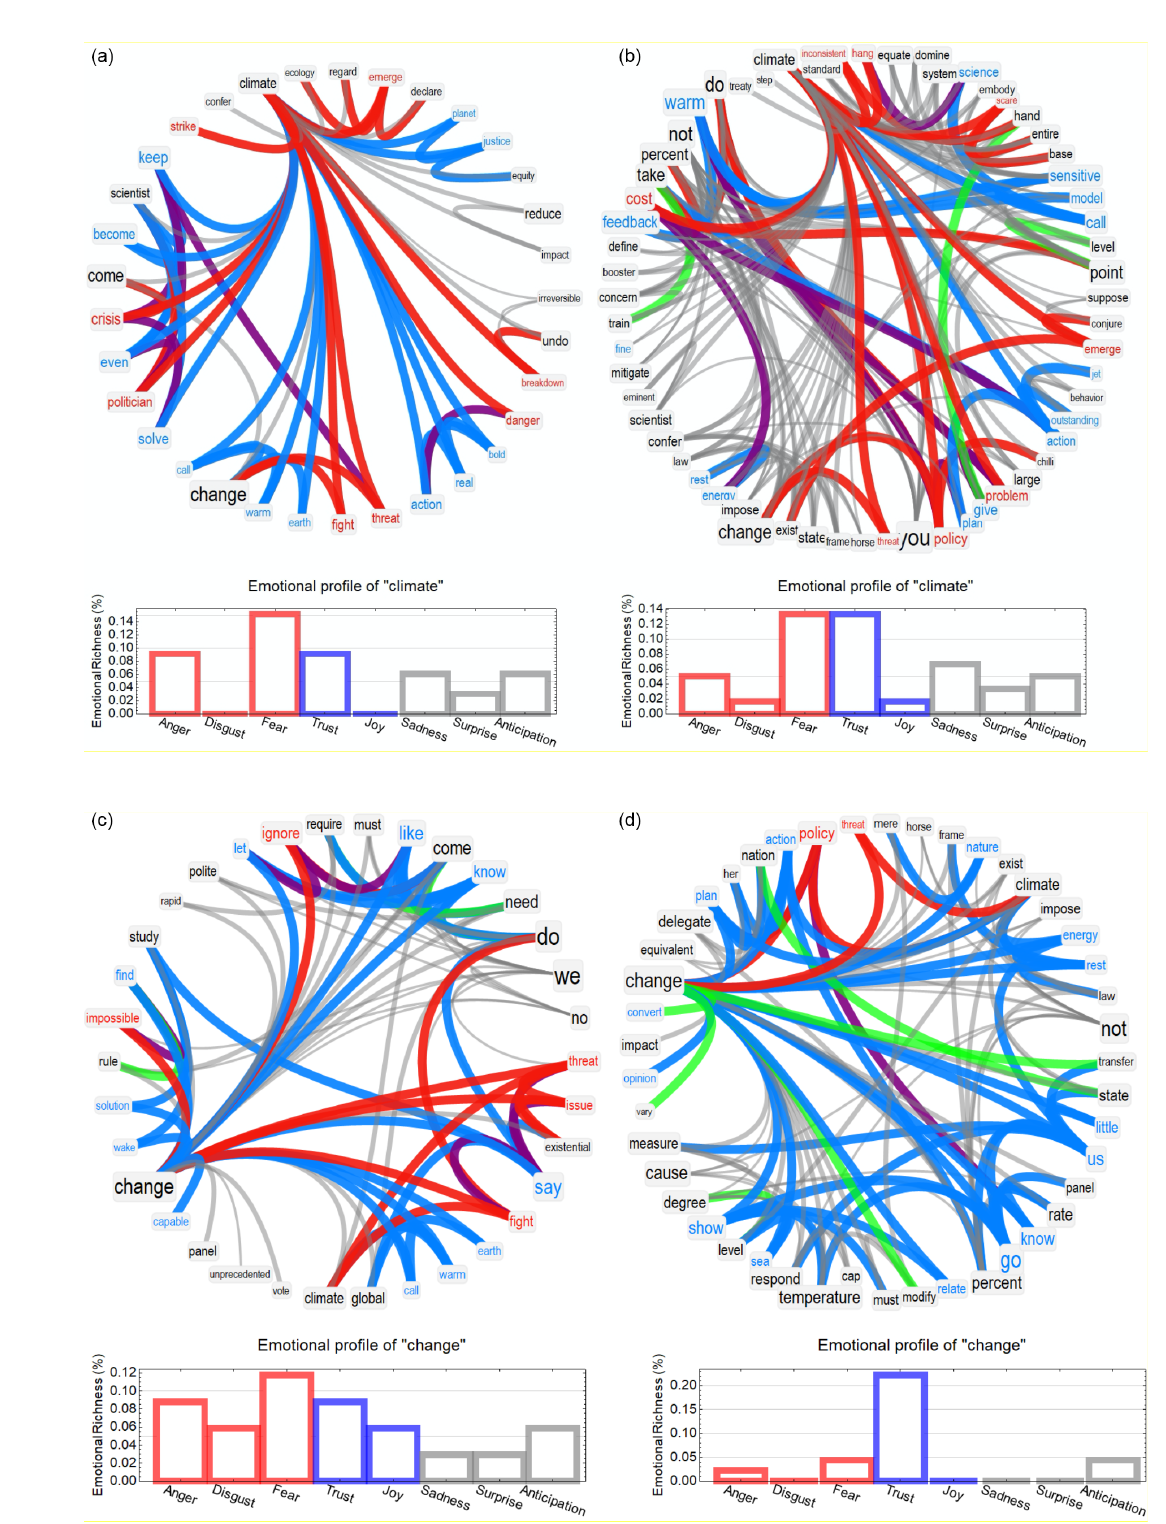
Figure 1. Speakers’ mindset reconstruction around “climate” (a, b) and “change” (c, d) in the speeches of Greta Thunberg (a, c) and Christopher Monckton (b, d) . Links indicate syntactic and semantic relationships between words in speeches. Links are coloured if linking at least a positive, negative, or neutral word or synonyms (blue, red, grey, green). Blue, red, and black (positive, negative, and neutral) words indicate how they are perceived in language according to the NRC Emotion Lexicon (see Sect. 2). Font size expresses the relative importance of the words, reflecting their centrality in the speeches. Emotions are self-explanatory, except for anticipation, which is a projection into future expectations (see Stella, 2020). We refer the reader to Lexicon 1 for an interpretation of the figure. Earth Syst. Dynam., 13, 1473–1489, 2022